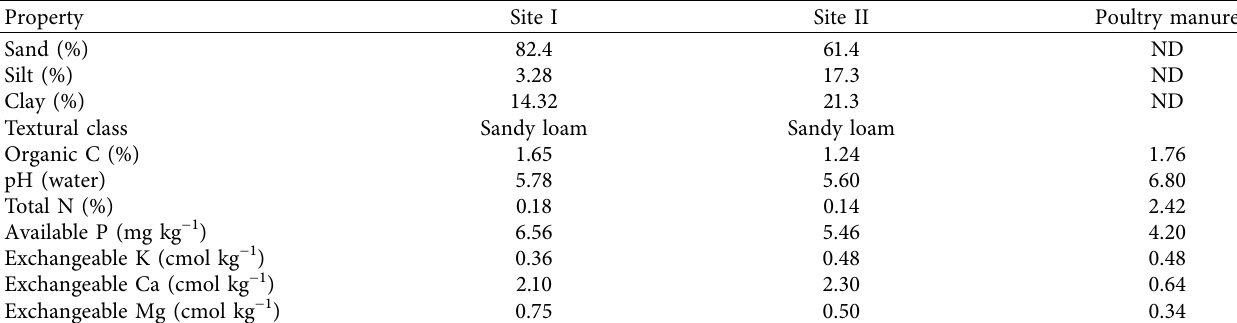
Table 1: Initial soil characteristics at the sites before